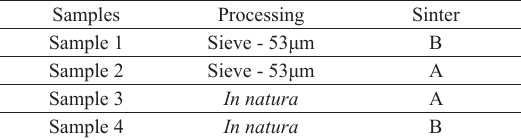
Table 1. Nomenclature of the